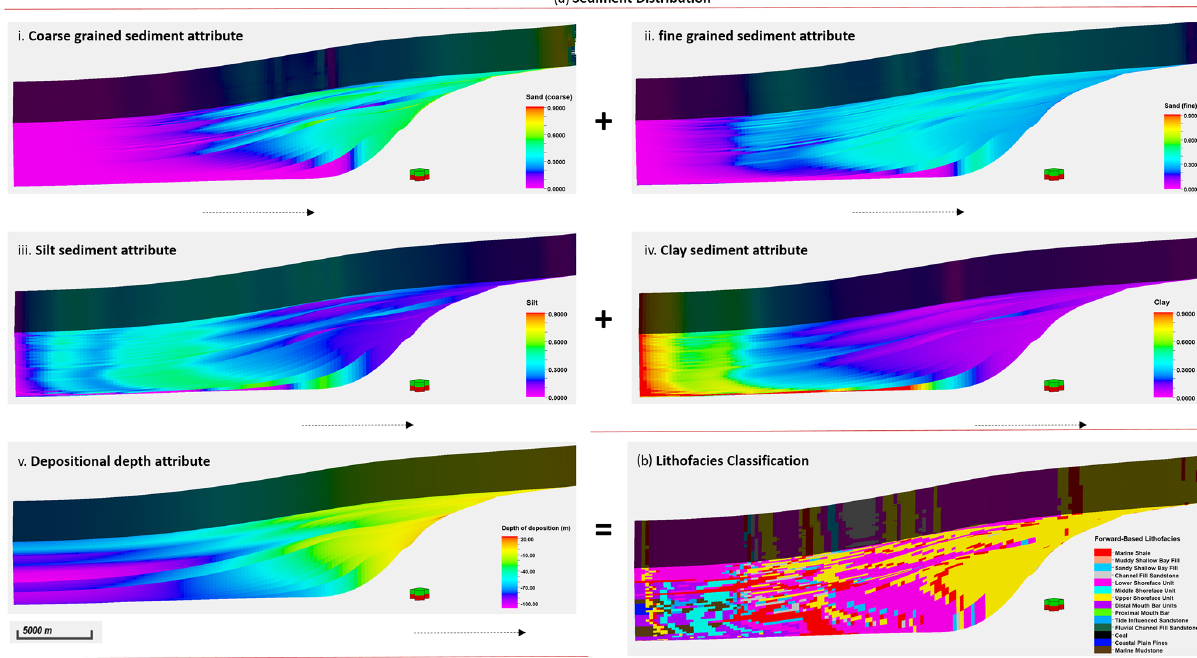
Figure 7. (a) Sediment distribution patterns in the geological process modelling software. (b) Lithofacies classification using the property calculator tool in